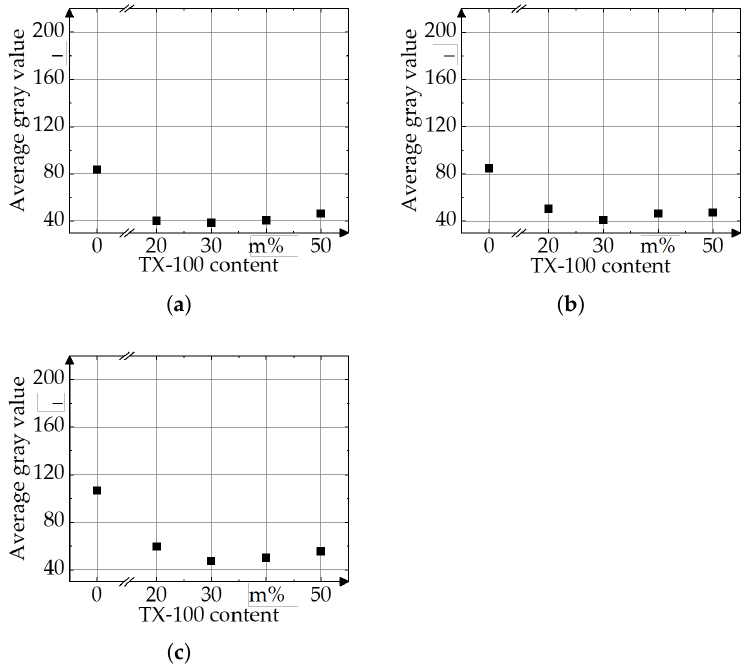
Figure 11. Average gray value of CB dispersions as a function of TX-100 content at different times ( a ) as-prepared ( b ) after 1 h and ( c ) after 12 h (see Table